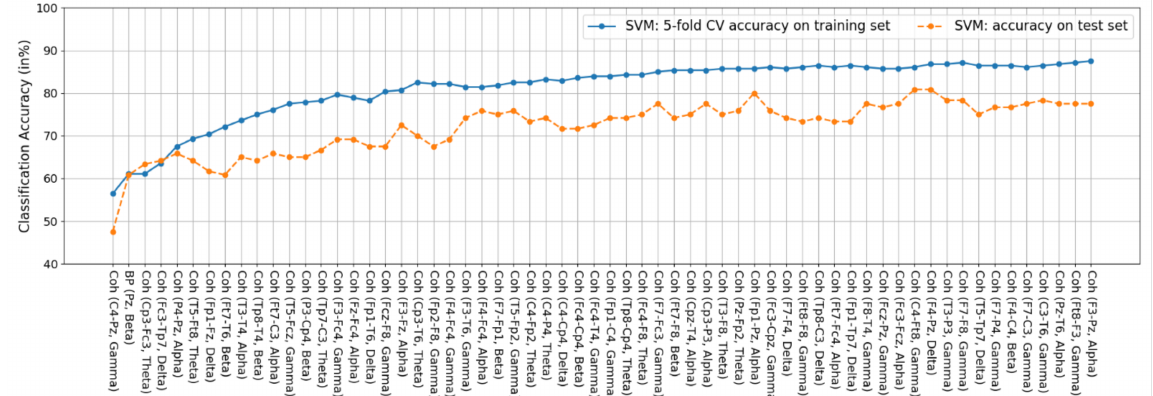
Figure A3. Features of the SVM classifier. Among the 62 features, 61 are coherence features and the remaining one is the beta BP feature at